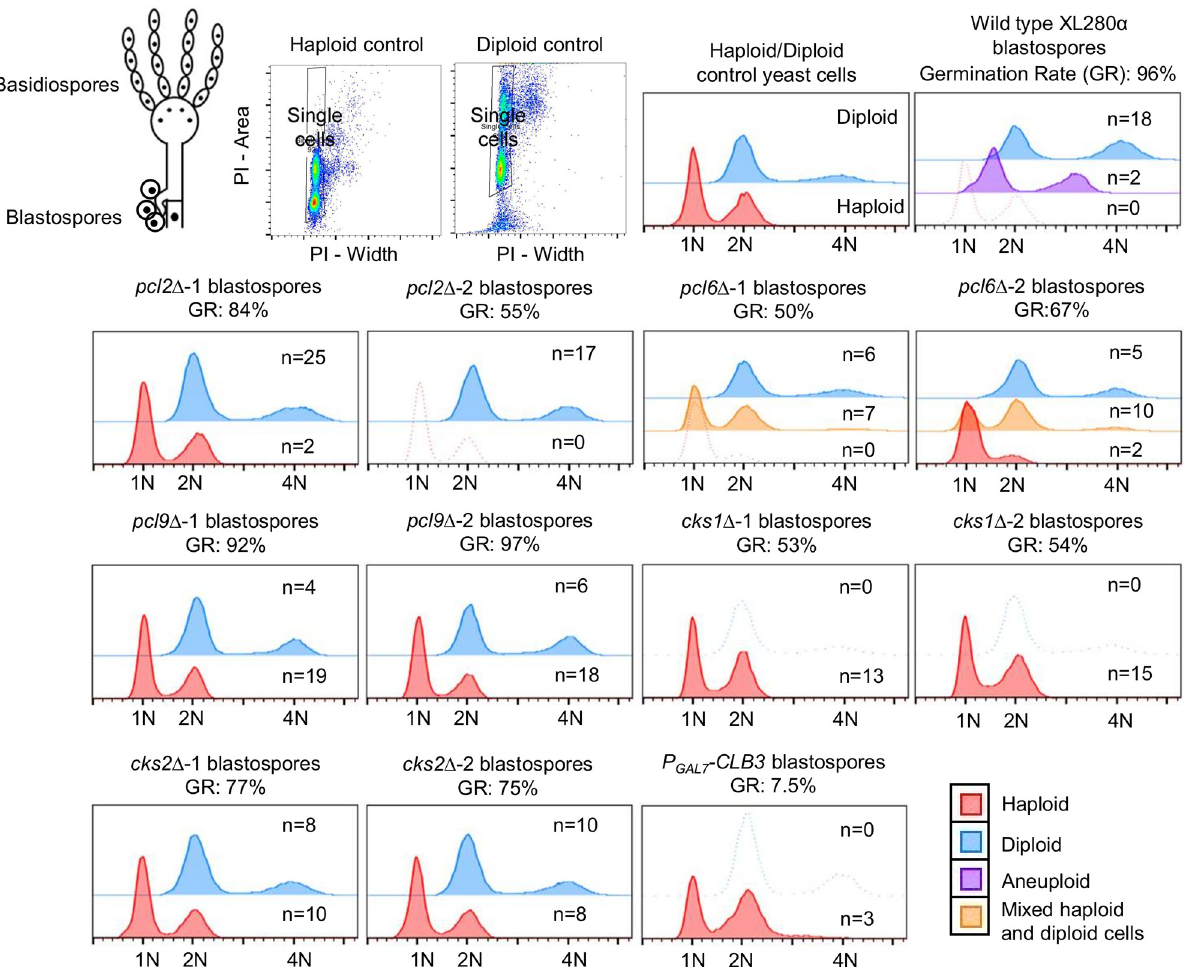
Fig 2. Cell cycle regulating genes contribute to blastospore diploidization during unisexual reproduction. Ploidy of single colonies derived from microscopically dissected blastospores were determined by FACS. Schematic diagram showing basidiospores and blastospores and representative gating strategy for single cells were provided at top left. Representative FACS results for haploid (red), diploid (blue), aneuploid (purple), or mixed haploid/diploid (yellow) were overlay-plotted with half offset.